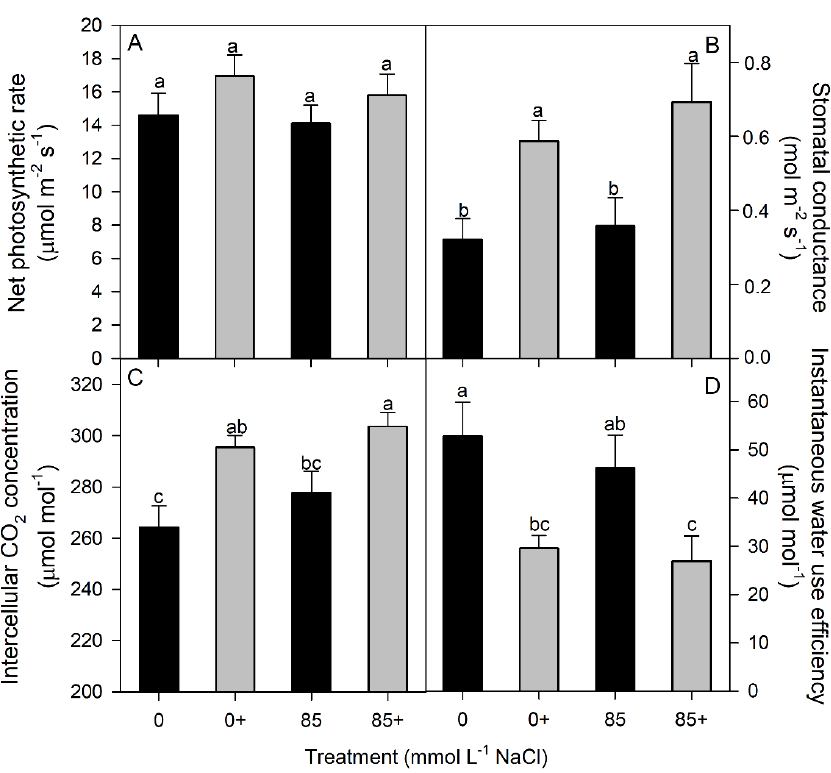
Figure 4. Net photosynthetic rate ( A ), stomatal conductance ( B ), intercellular CO 2 concentration ( C ), and instantaneous water use efficiency ( D ) of Swiss chard after 30 d of treatment with 0 and 85 mmol L −1 NaCl, non-inoculated and inoculated (+). Each value represents the mean of eight replicates ± SE. Different letters indicate means that are significantly different from each other (ANOVA; Duncan test, p < 0.05). Table 1. Concentrations of chlorophylls a and b , pheophytine a , β -carotene, lutein, neoxanthin, violaxanthin, and zeaxanthin ( µ g g − 1 ) and De-Epoxidation State in Swiss chard leaves after 30 d of treatment with 0 and 85 mmol L − 1 NaCl, non-inoculated and inoculated (+). Each value represents the mean of six replicates ± SE. Different letters indicate means that are significantly different from each other (ANOVA; Duncan test, p <0.05).